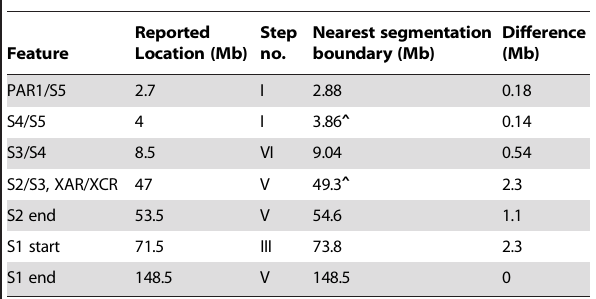
Table 1. Boundaries of X-chromosome features showing correspondence with segmentation boundaries obtained from the first six steps (see Methods).